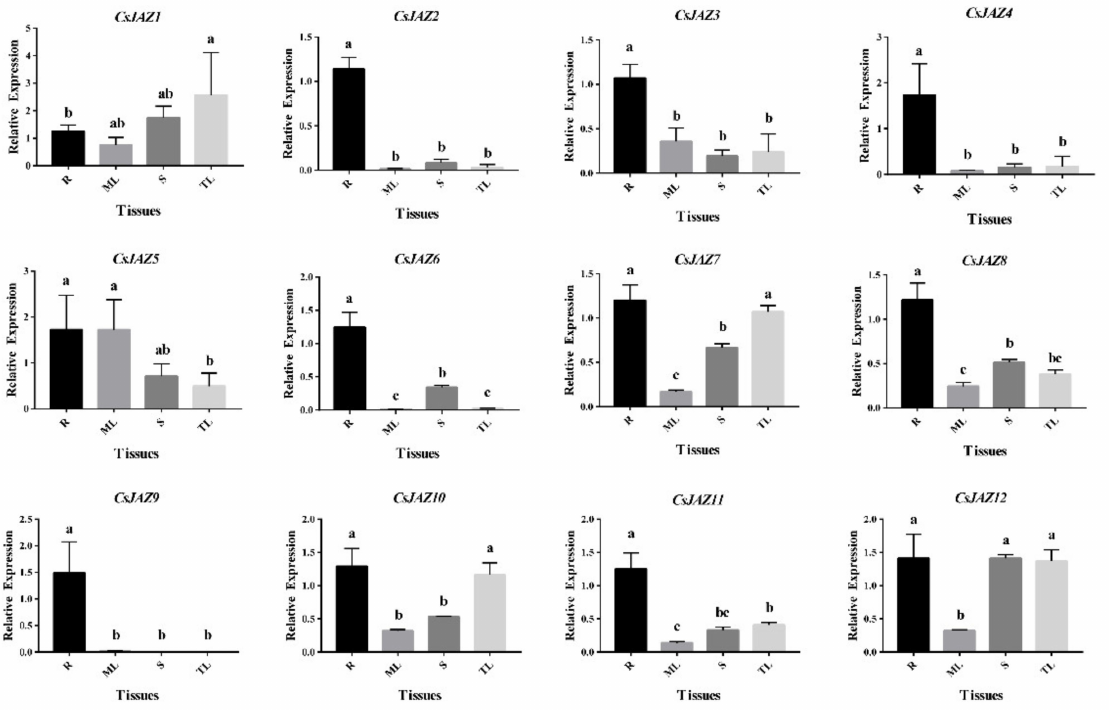
Figure 3. Quantitative RT–PCR analysis of expression of CsJAZ genes in di ff erent tea tissues. Data presented in the quantitative RT–PCR analysis were mean values and standard deviation of three biological replicates of di ff erent tissues and three technical replicates in each biological sample. The y -axis is the relative expression level. The di ff erent lower case letters above bars indicated the signifcance ( p < 0.05) of the relative expression level between two samples. R: roots; ML: mature leaves; S: stems; TL: tender